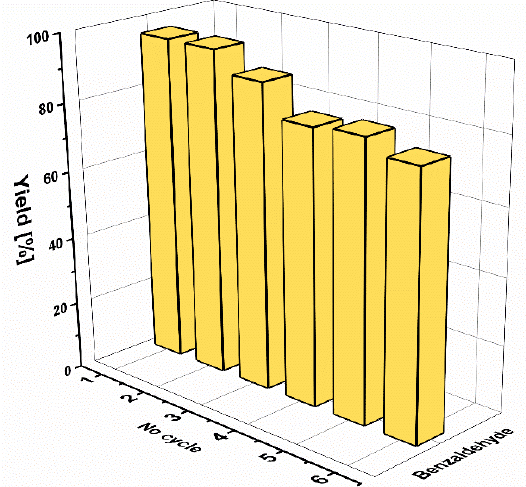
Figure 4. The yields of benzaldehyde in six consecutive cycles using N-AgNPs (performed according to the description of Table 3 Experiment 1).